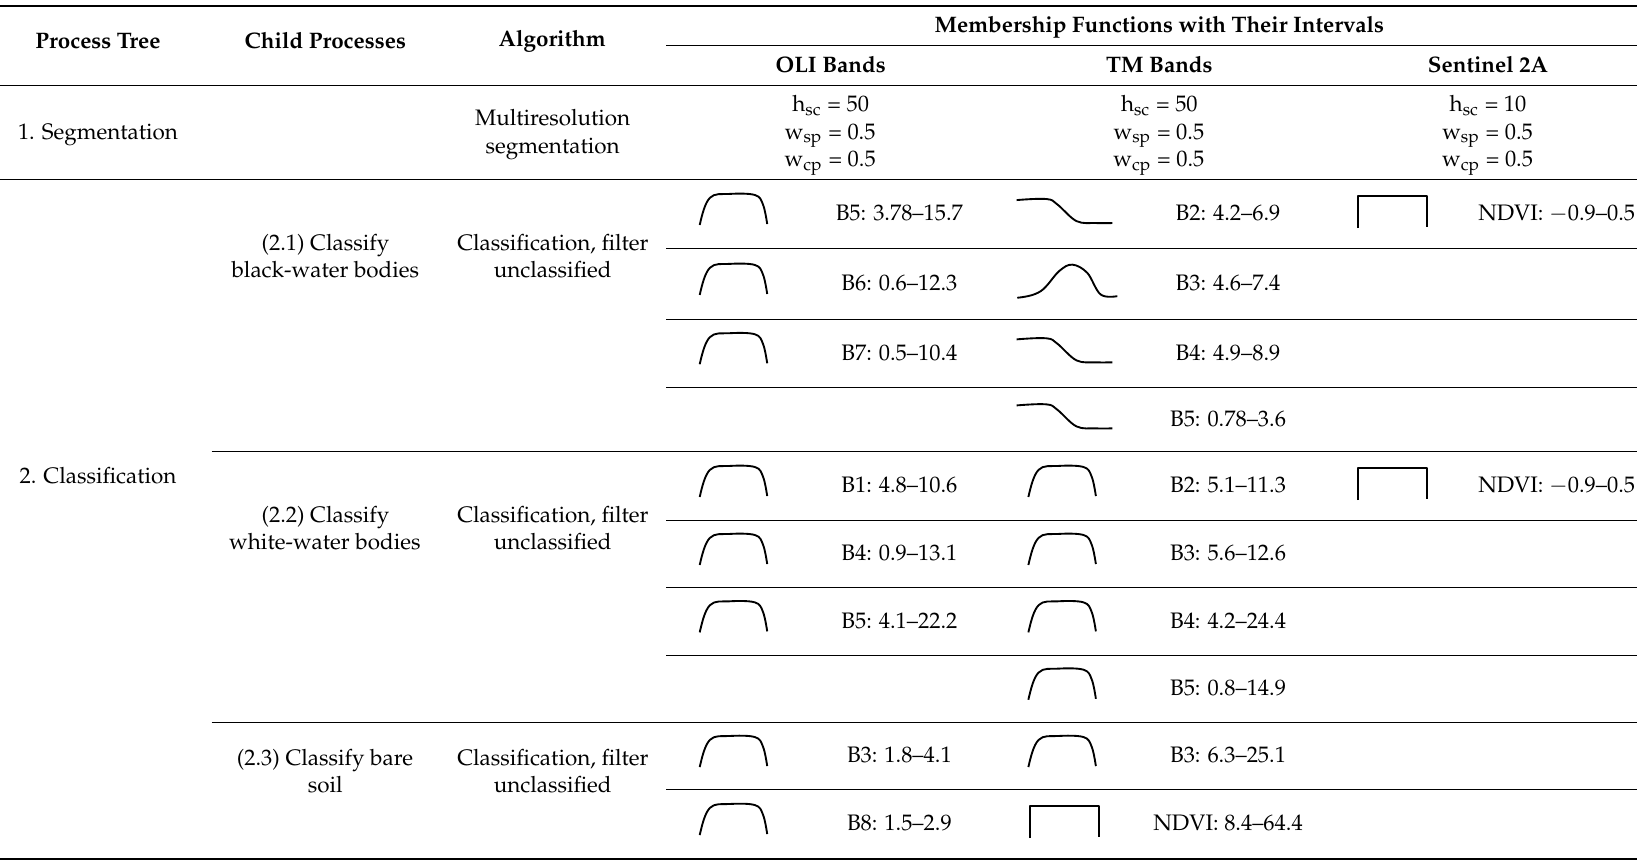
Table 1. The process tree, child processes, algorithms, and membership functions used in the LCLU classification following the GEOBIA approach.